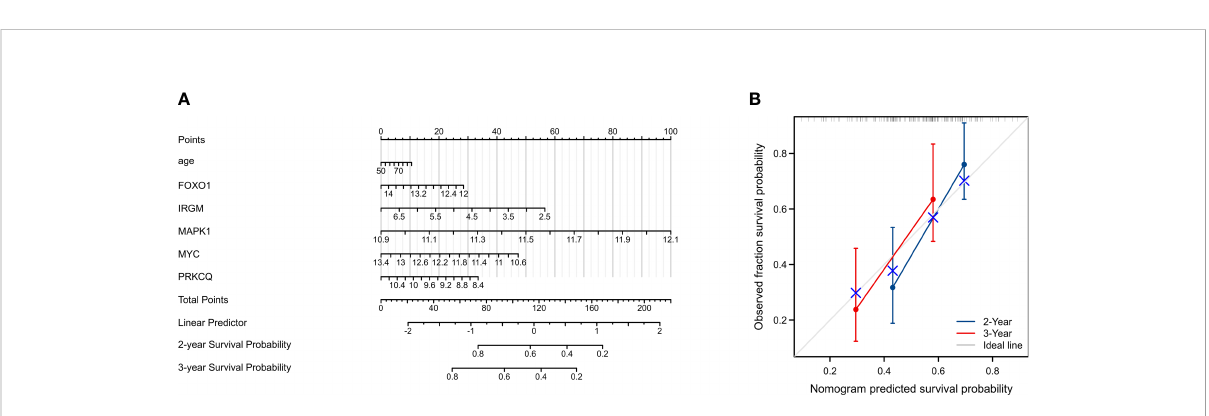
FIGURE 5 Construction and evaluation of a nomogram for predicting 2-, and 3-year overall survival rates of IPF patients. (A) Nomogram for predicting 2-, and 3-year overall survival of IPF patients. (B) Calibration curves showing the probability of 2-, and 3-year overall survival between the prediction and the observation.